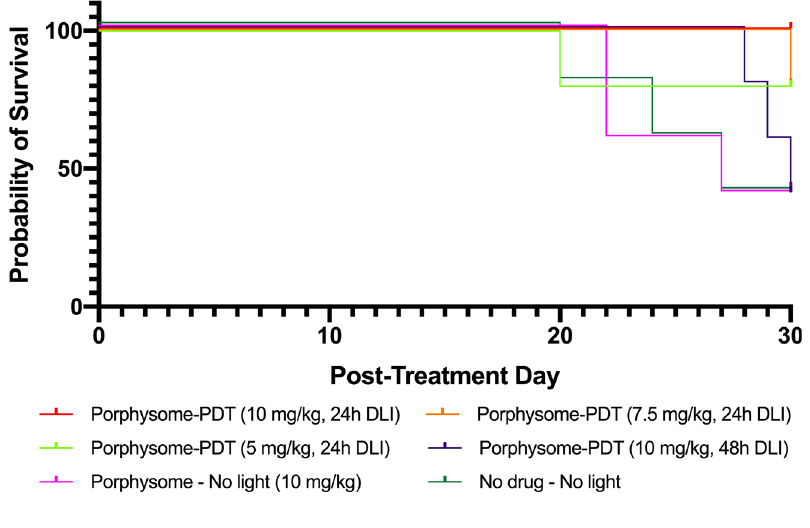
Figure 5: Kaplan – Meier plots of treatment and control groups.